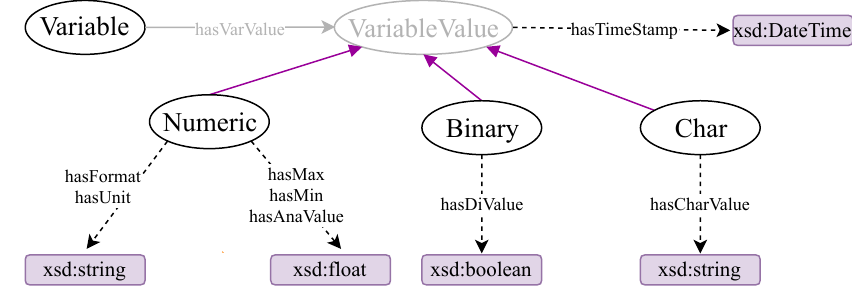
Figure 6. Graph representation of variables’ attributes.